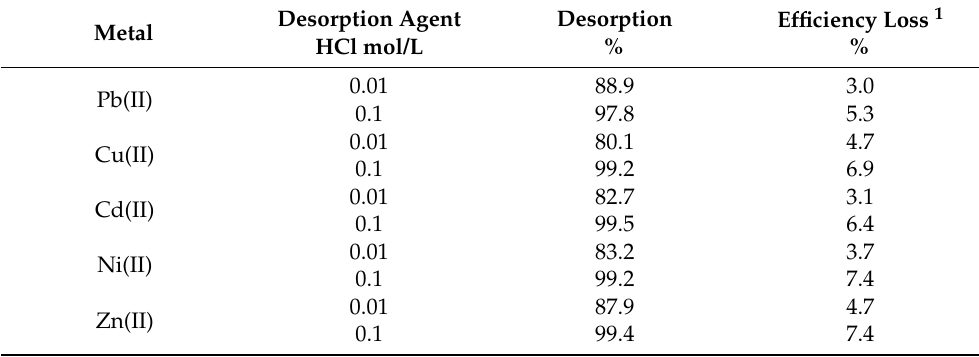
Table 5. Results of desorption tests from the loaded